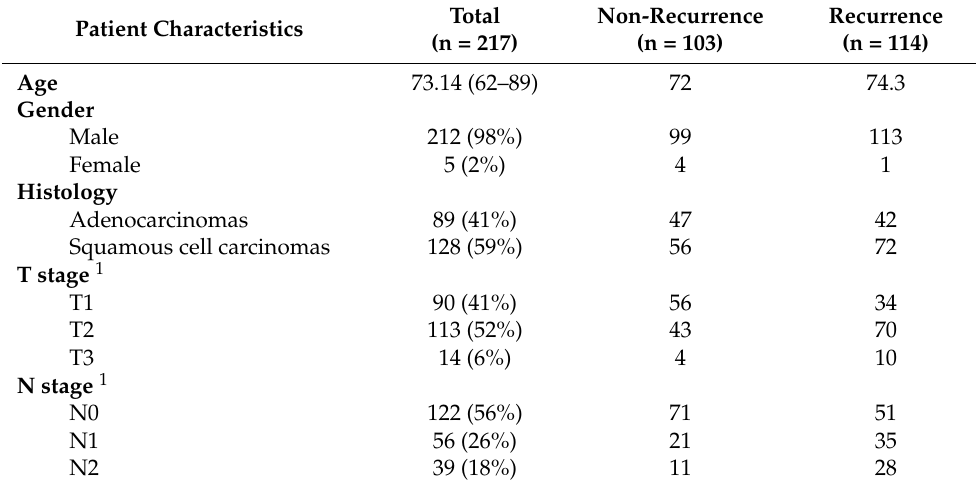
Table 1. Patient characteristics.